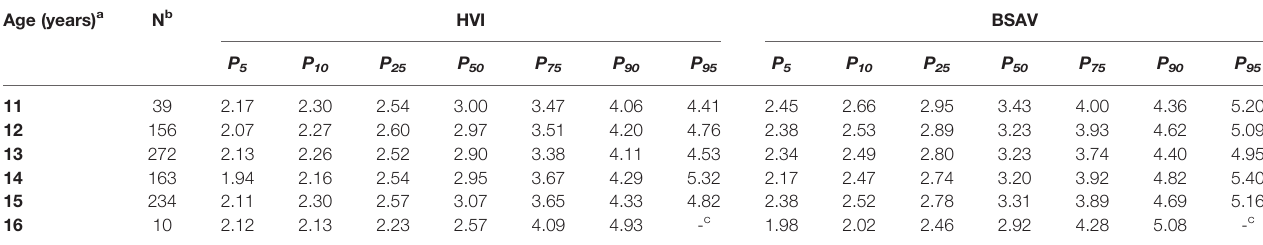
TABLE 4 | Percentile values for height thyroid volume index (HVI) and body surface area thyroid volume index (BSAV) strati fi ed by age in girls aged 11 to 16 years.